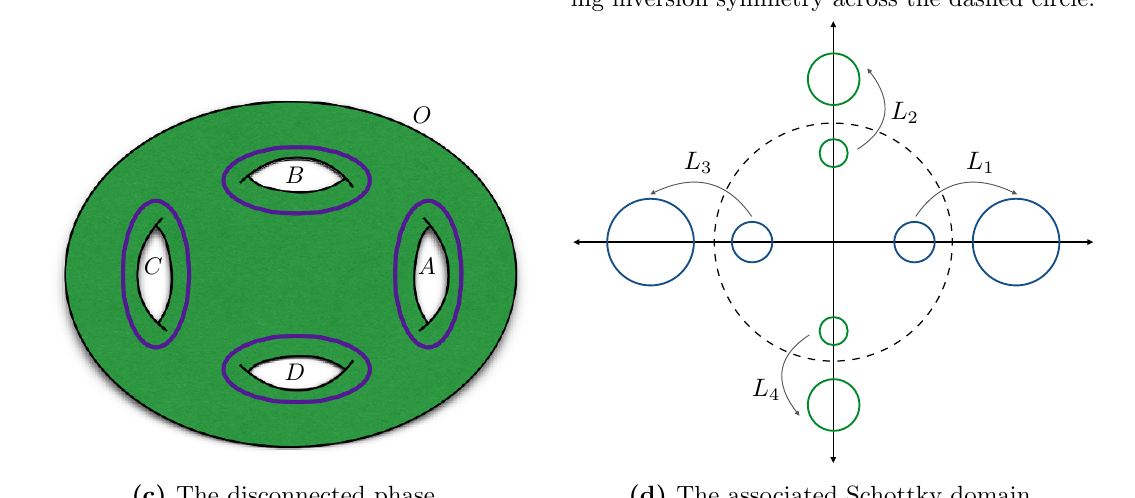
Figure 2 . The choices of contractible cycles corresponding to the connected and disconnected phases and the corresponding Schottky